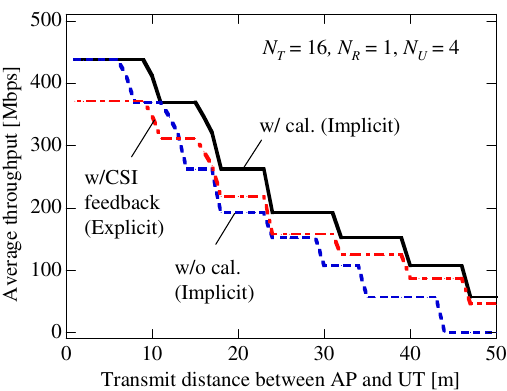
Figure 14. Throughput vs. distance between base station (BS) and user terminal (UT) with and without calibration, and with channel state information (CSI)